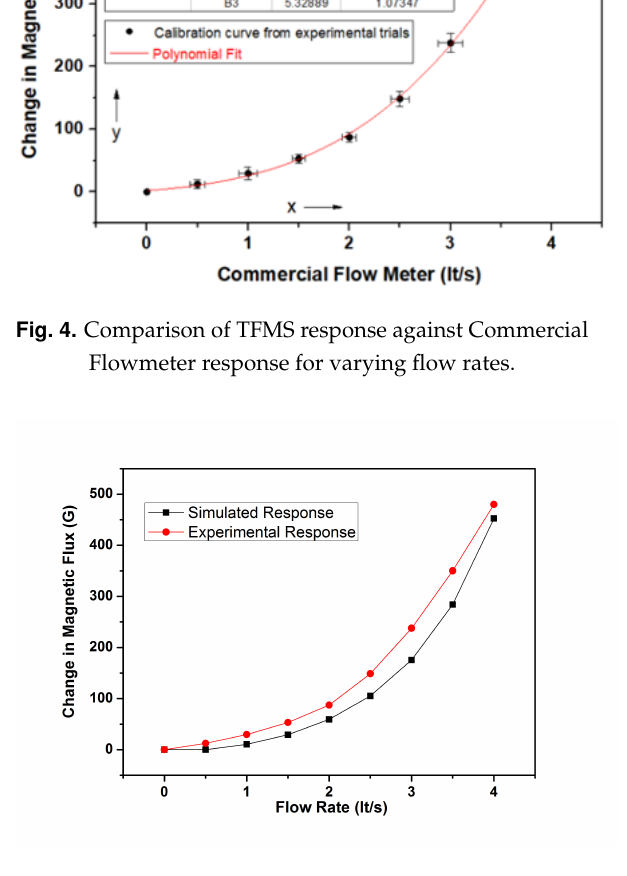
Fig. 5. Comparison of experimental and simulated